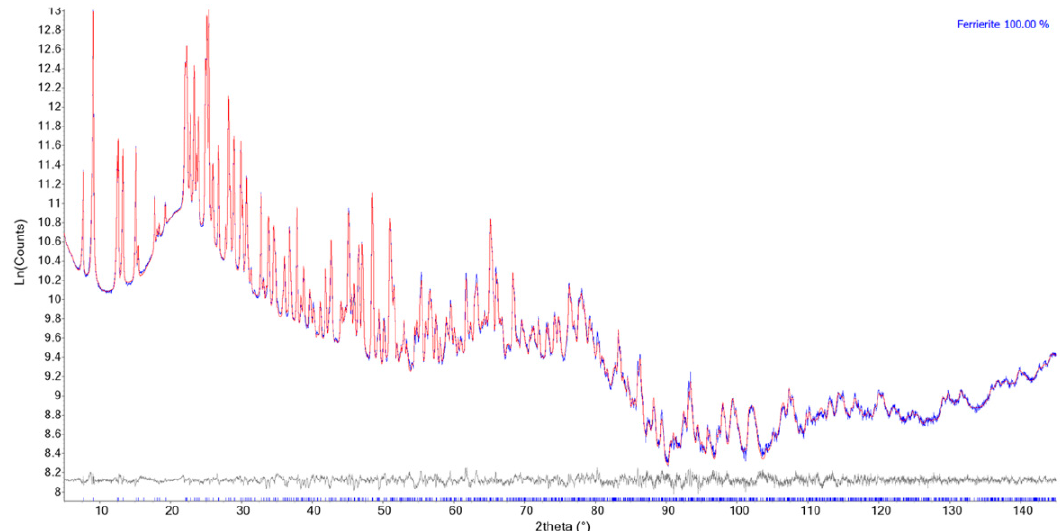
Figure 2. Conventional Rietveld plots of FER5 sample. Intensity is reported on a logarithmic (natural) scale. Blue continuous line: experimental; red continuous line: calculated; continuous grey line: difference; below: vertical ticks represent the position of calculated Bragg reflections.